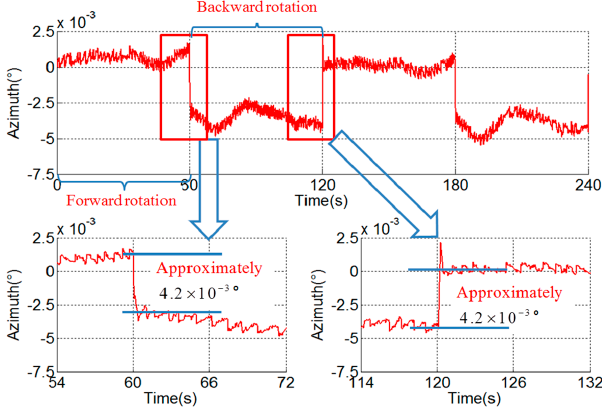
Figure 6. Stair error of azimuth ( ω = 6°/s).